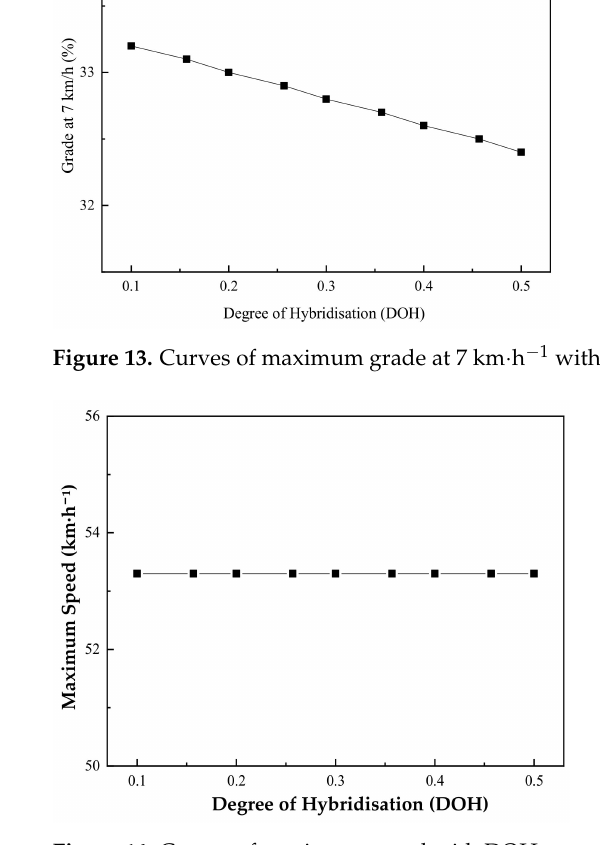
Figure 14. Curves of maximum speed with